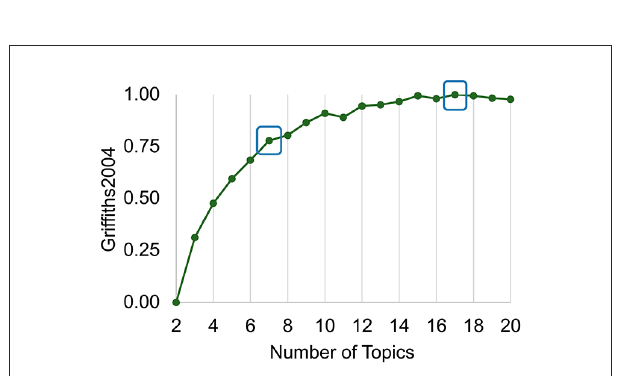
FIGURE4 Latent Dirichlet Allocation of Griffiths measure. Griffiths measure also referred to as Griffiths and Steyvers (2004) along the y-axis vs. the number of topics along the